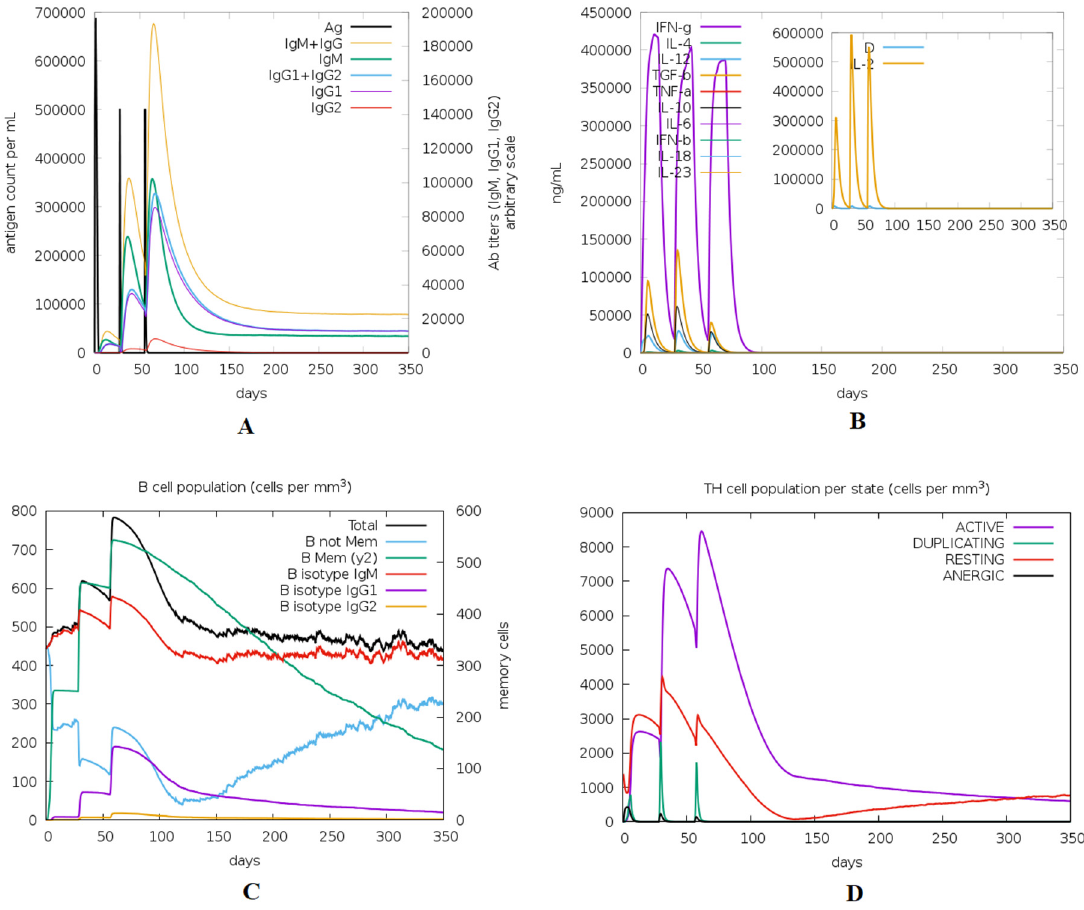
Figure 12. Immune response predicted through ImmSim server after the injection of the designed multitope vaccine. ( A ) Levels of the produced antibodies. ( B ) Cytokines level, ( C , D ) demonstrate the B and T cell population